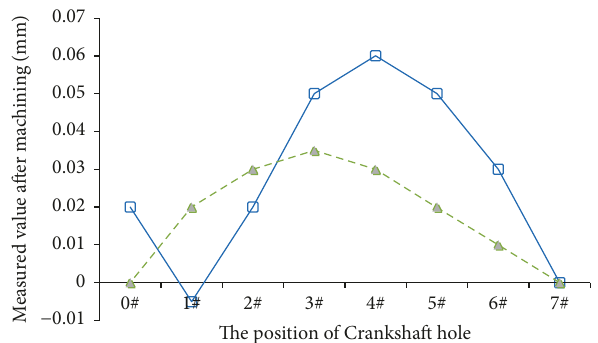
Figure 8: The distribution contrast diagram of crankshaft holes.